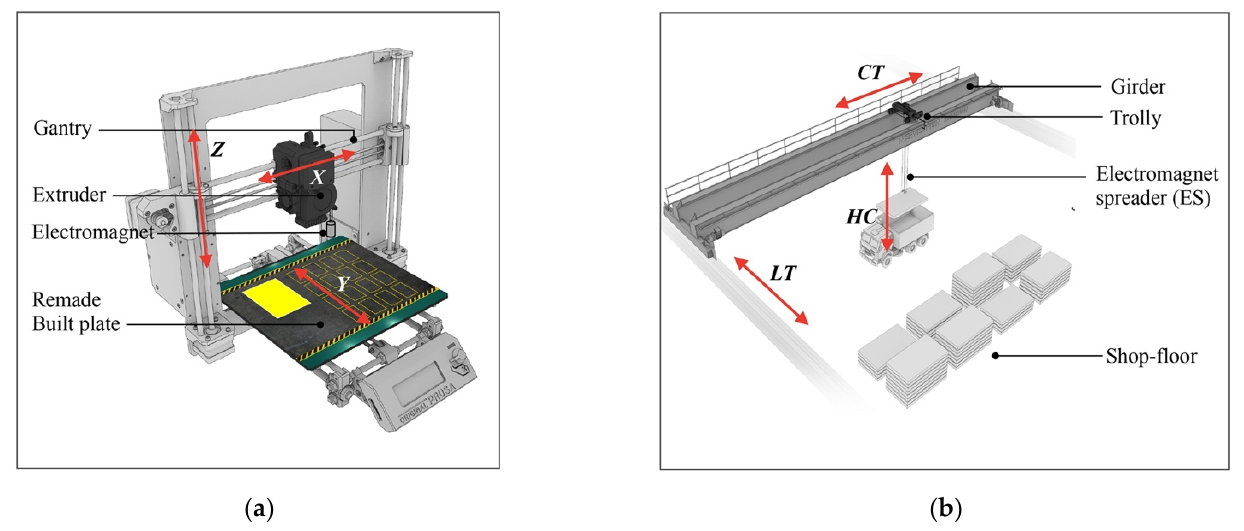
Figure 1. Comparison of mechanism between a Cartesian 3D printer and an EOT crane. ( a ) The mechanism of a cartesian 3D printer. ( b ) The mechanism of an EOT crane.